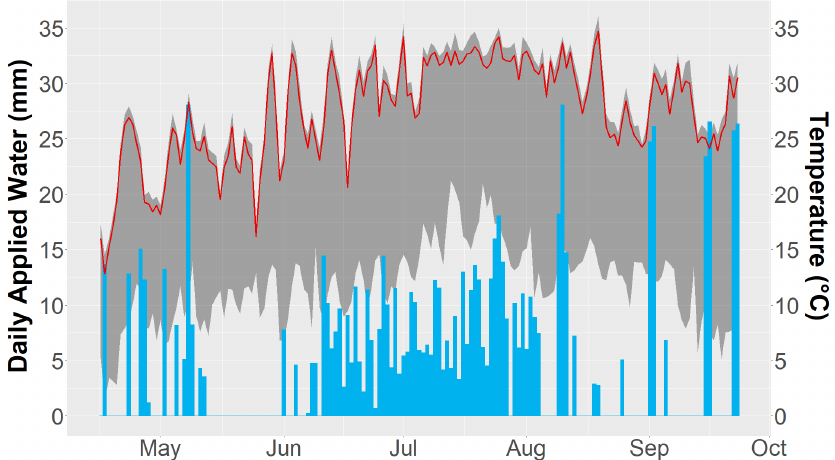
Figure 3. Daily air temperature ◦ C (right axis) for the 2018 growing season is shown for mid-day (red line) as well as maxima-minima (gray band). Applied irrigation for each day in mm (left axis) is shown as blue